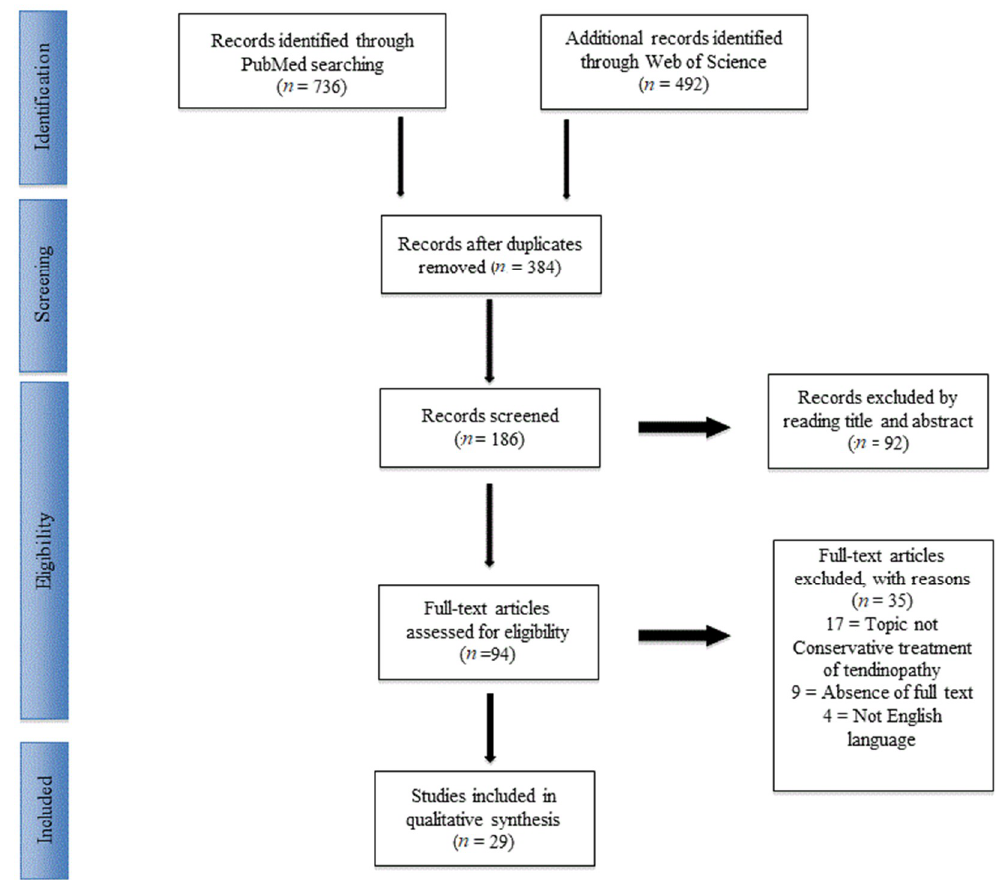
Figure 1. PRISMA (Preferred Reporting Items for Systematic Reviews and Meta-Analysis) flowchart of the systematic literature review.